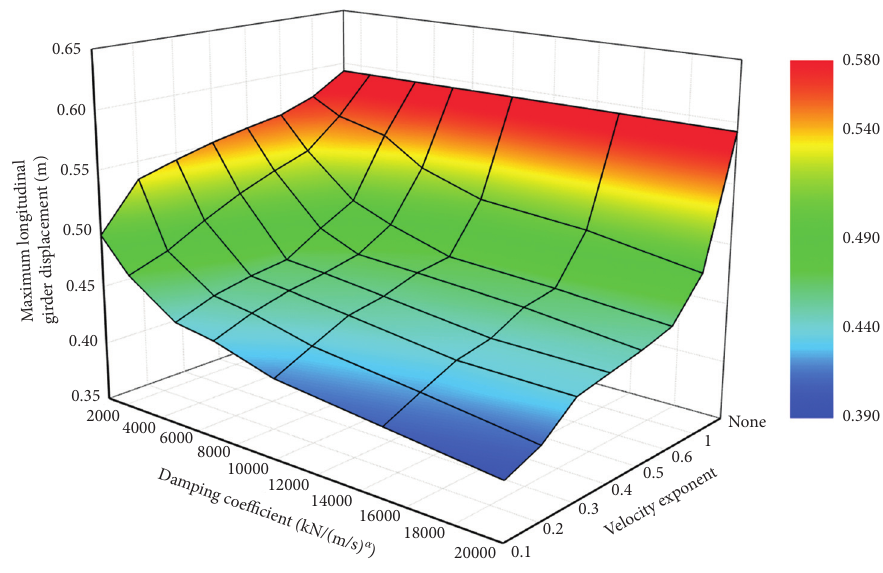
Figure 17: Maximum longitudinal girder displacement W